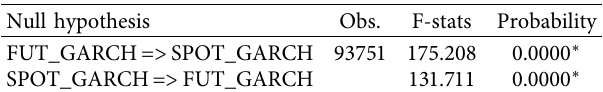
Table 8: Test of Granger causality between the market volatilities of the spot and futures indices.